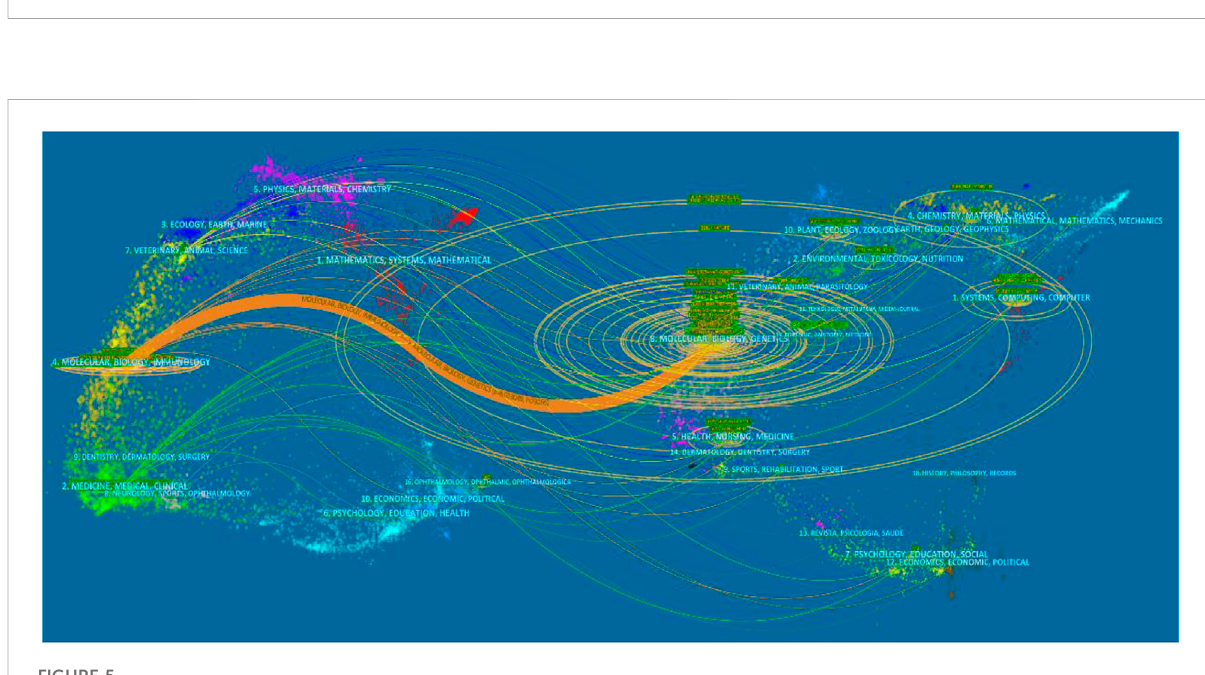
Figure 5. The cluster analysis of citing articles (the left side) belongs to journals focusing on the fi eld of molecular/biology/ immunology research. Also, the cluster analysis of cited articles (the right side) belongs to journals focusing on the fi eld of molecular/biology/genetics research. The